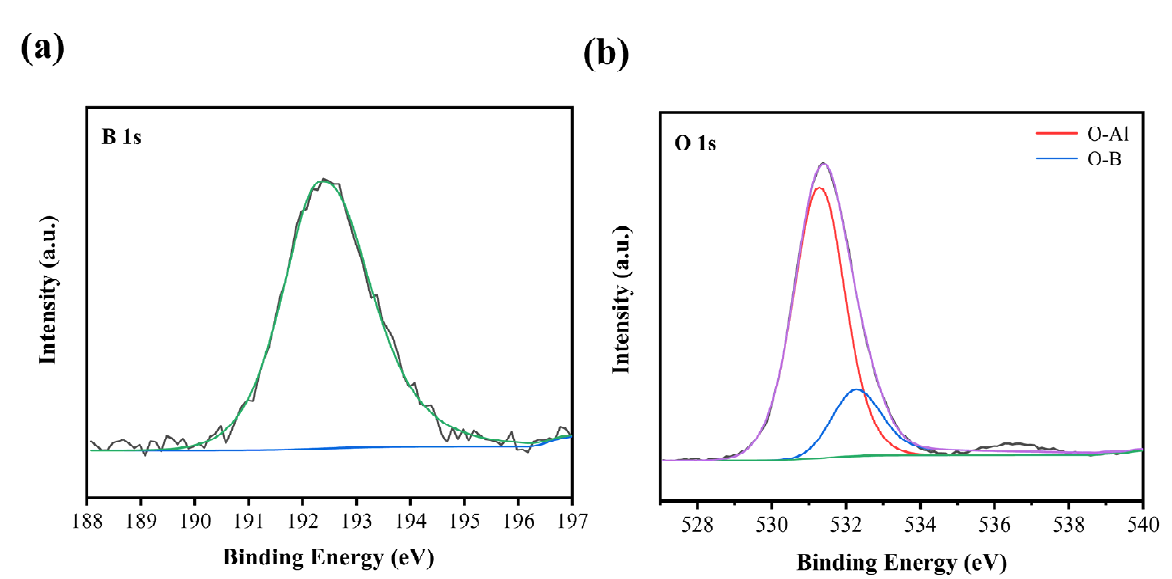
8 of 12 Figure 8. Standard Gibbs free energy of oxidation reaction of B 4 C and SiC. As crack healing was attributed to the oxidation reaction of the healing agent, the recovery of performance depended mainly on the healing time and temperature. The samples were observed before and after heat treatment at 700 °C in air; it was observed